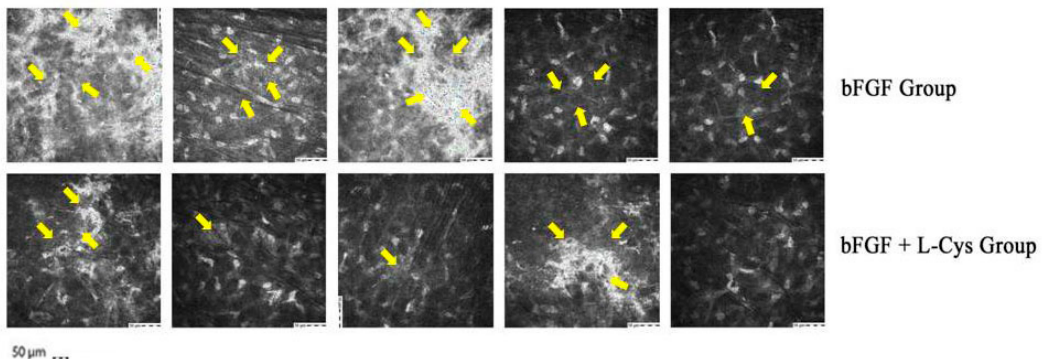
Figure 3. Representative ConfoScan 4 confocal microscope images of the stroma of 5 patients who received only bFGF (bFGF Group) and of 5 patients who were administered topical with bFGF plus oral l -cysteine supplementation (bFGF + l -cys Group). Images were taken at 6 months of follow-up. Yellow arrows indicate the light scattering regions of cornea .